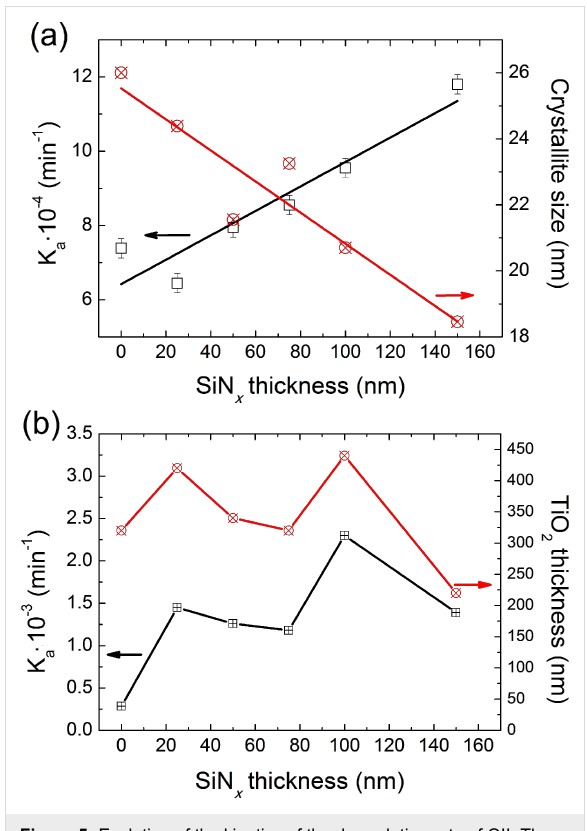
Figure 5: Evolution of the kinetics of the degradation rate of OII. The crystallite size and TiO 2 thickness of (a) a SG-TiO 2 film and (b) the magnetron sputtered TiO 2 film as a function of SiN x